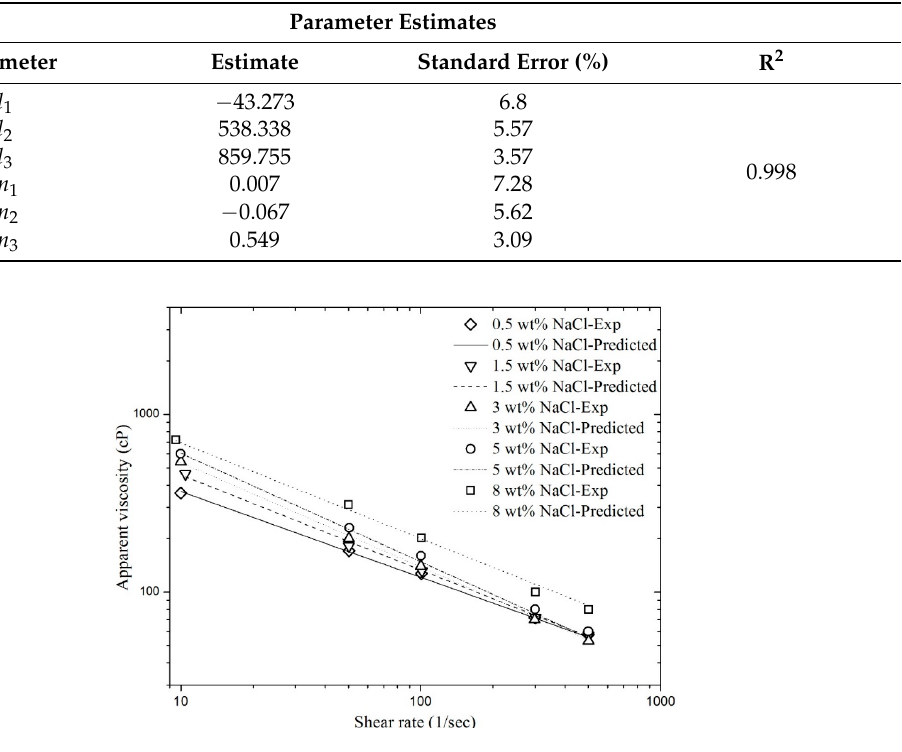
Figure 9. Matches between the experimental data and the predicted values (using Equation (9)) of CO 2 foam apparent viscosity as a function of shear rate and salinity.